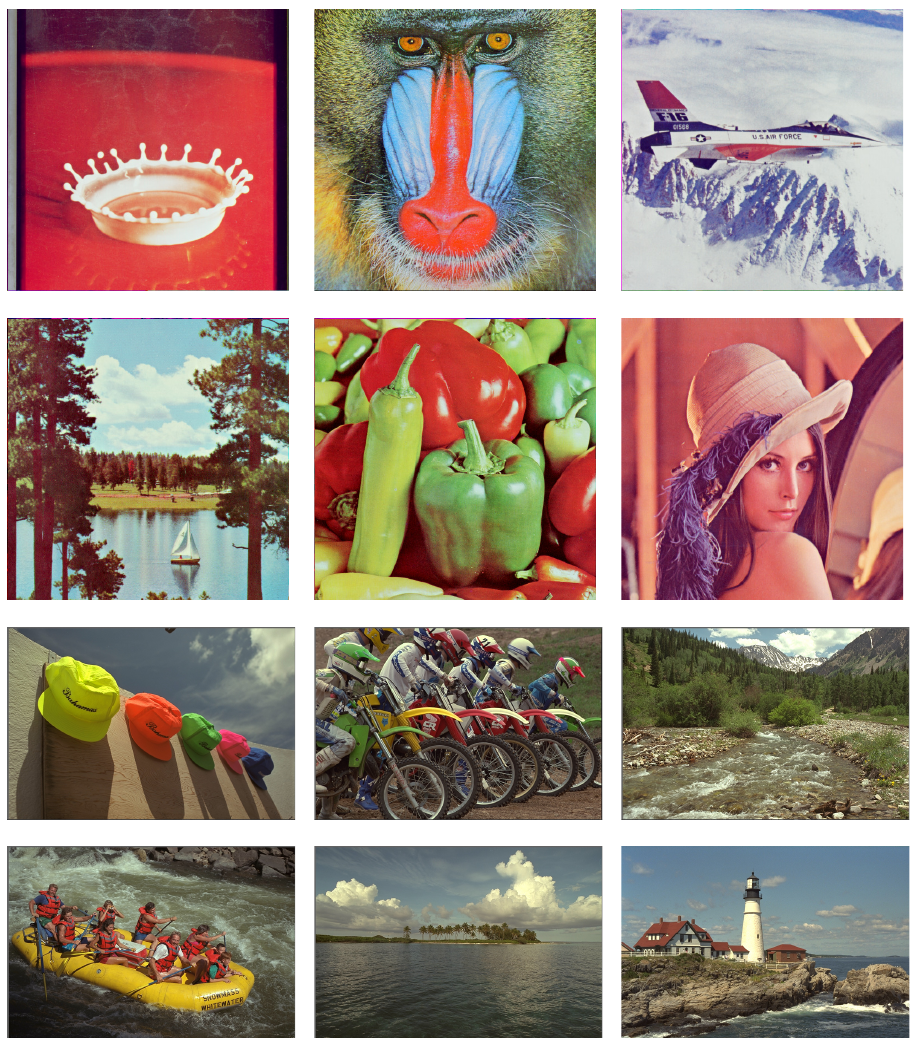
Figure 6. The set of test images, in order from I1–I12.